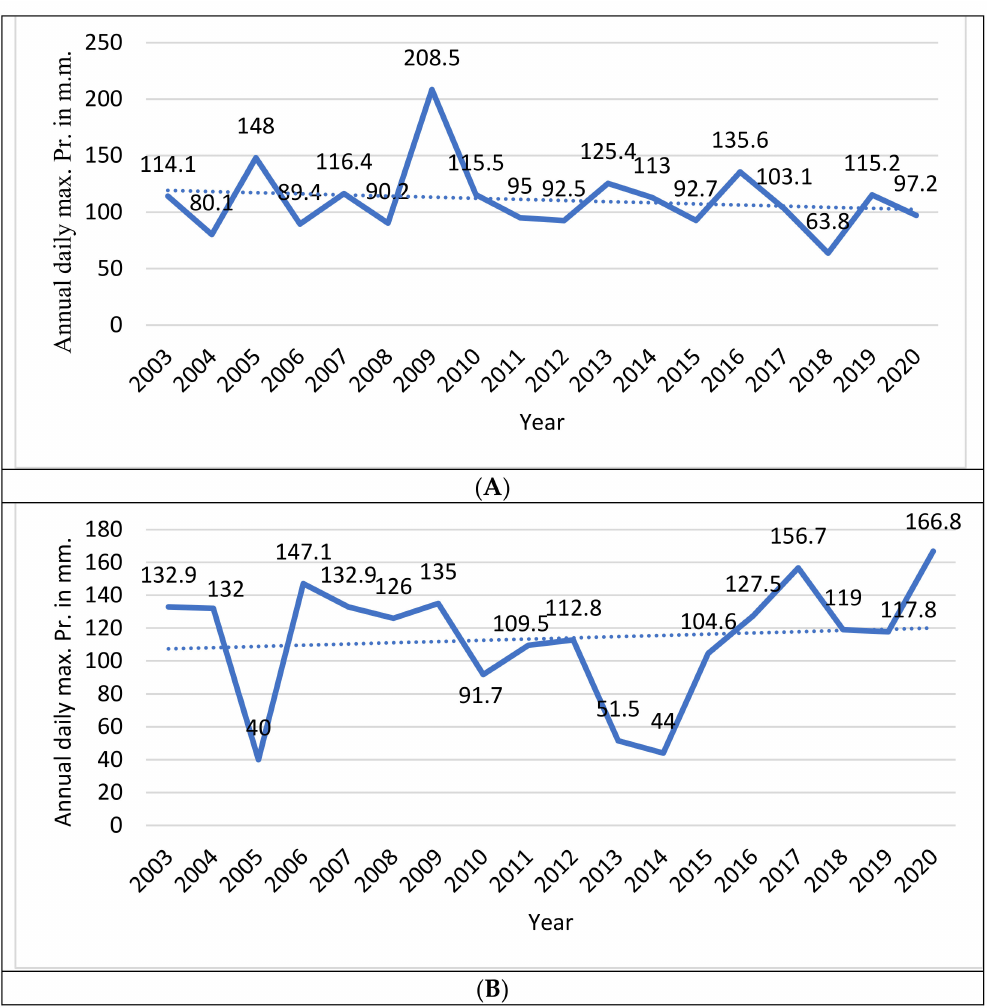
Figure 3. Observed annual daily maximum precipitation trend of ( A ) Baglung and ( B ) Lamjung. Baglung, Bandipur, Manang Bhot, Tatopani, and Damauli were among fifteen